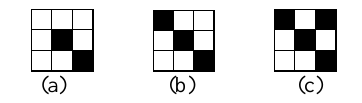
Figure 7. a Endpoint. b Connecting point. c Crossing